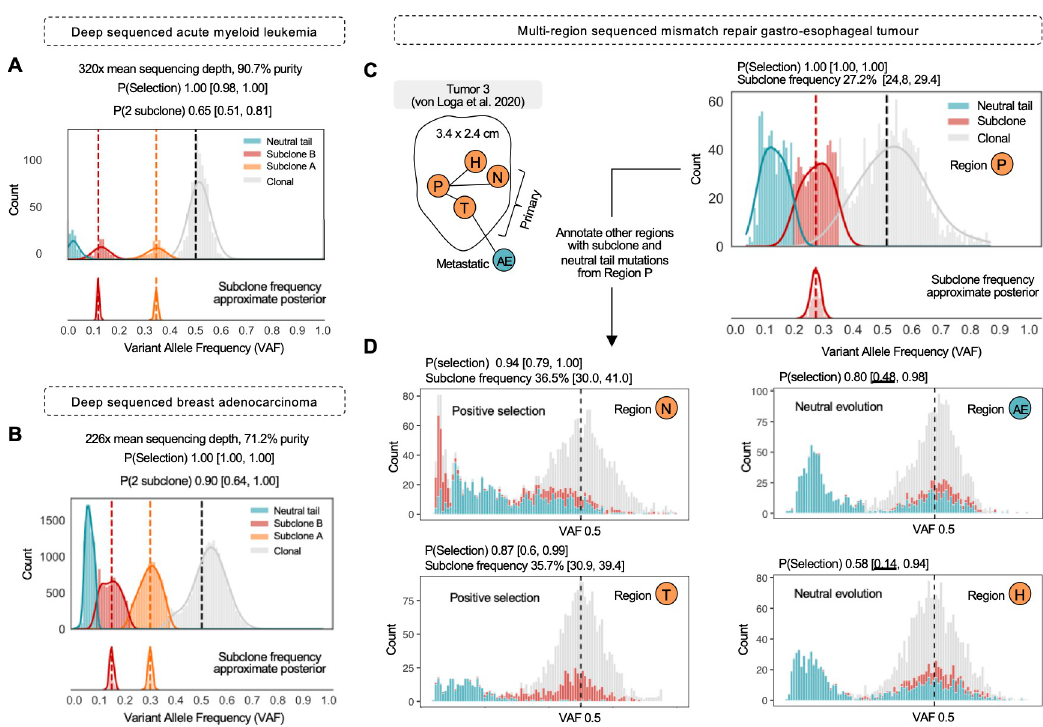
Fig 3. TumE estimates in deep whole-genome or whole exome sequenced tumour biopsies. (A) A deep-sequenced primary acute myeloid leukemia (AML) sample from Griffith et al. [31]. TumE estimated two subclones, a neutral tail, and a clonal peak. P (Selection) indicates the probability of selection. P(0, 1, 2 subclone) indicates the probability estimate for the number of subclones. Each probability estimate is provided with the 89% equal-tailed interval generated from 50 Monte Carlo dropout samples. A sample is labeled positive selection if the lower bound of the 89% interval is above P = 0.5, and the number of subclones is assigned to a sample if the lower bound of the 89% interval is greater than 0.5 (Methods). Subclone frequency estimates are shown with the complete approximate posterior. (B) A deep-sequenced breast adenocarcinoma from the pan-cancer analysis of whole genomes (PCAWG) [11]. TumE estimated two subclones, a neutral tail, and a clonal peak. (C) We applied TumE to a single mismatch repair deficient (MMR) gastro-esophageal tumour [33] sequenced across 5 spatially distinct regions. We first identified an intermediate frequency subclone in region P with TumE. (D) Under the hypothesis that TumE could reveal the fixation process of region P subclones in other regions, we annotated each of the remaining regions with the clonal, subclonal, and neutral tail mutations identified in region P. We identified ongoing subclonal selection in 2 out of the 4 remaining regions (N and T) consistent with an increase in frequency of subclonal and neutral tail mutations from region P. In cases where neutral evolution was the most parsimonious explanation, we observed complete fixation of the region P subclonal mutations (region AE and